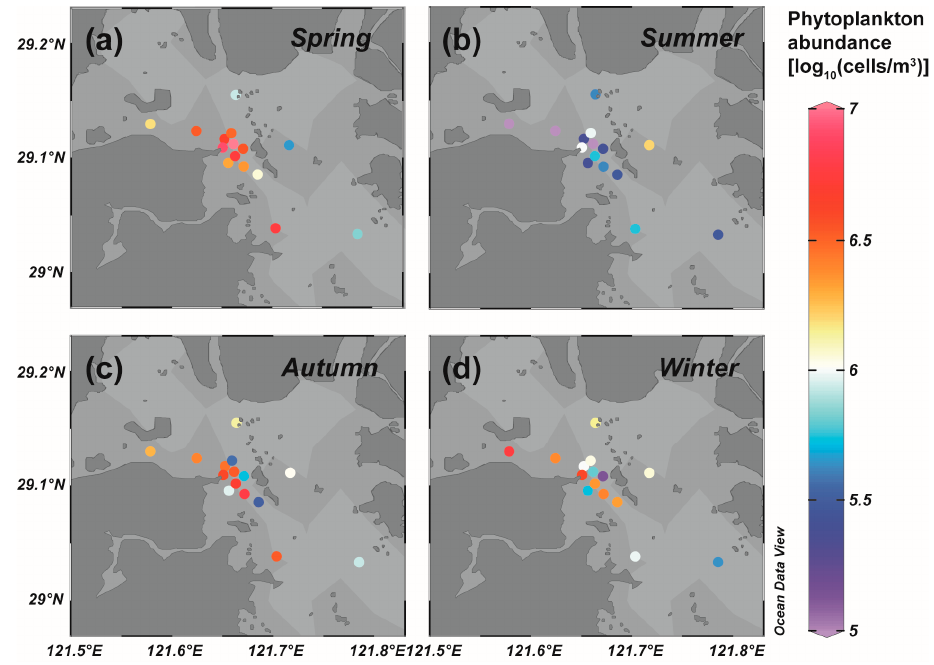
Figure 2 . Spatial and temporal distribution of phytoplankton abundance in Sanmen Bay in